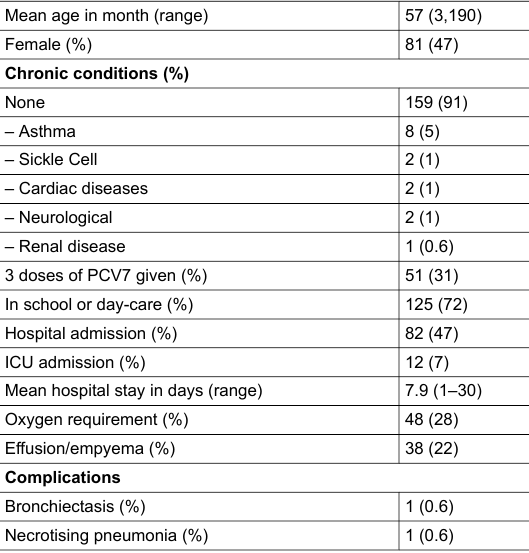
Table 1: Baseline characteristics of study population and CAP-related